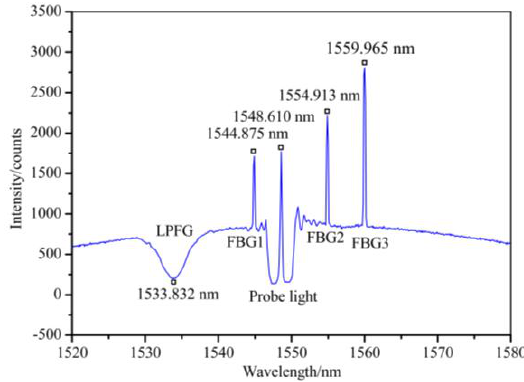
Figure 8. The measured spectrum of the XFG sensors.